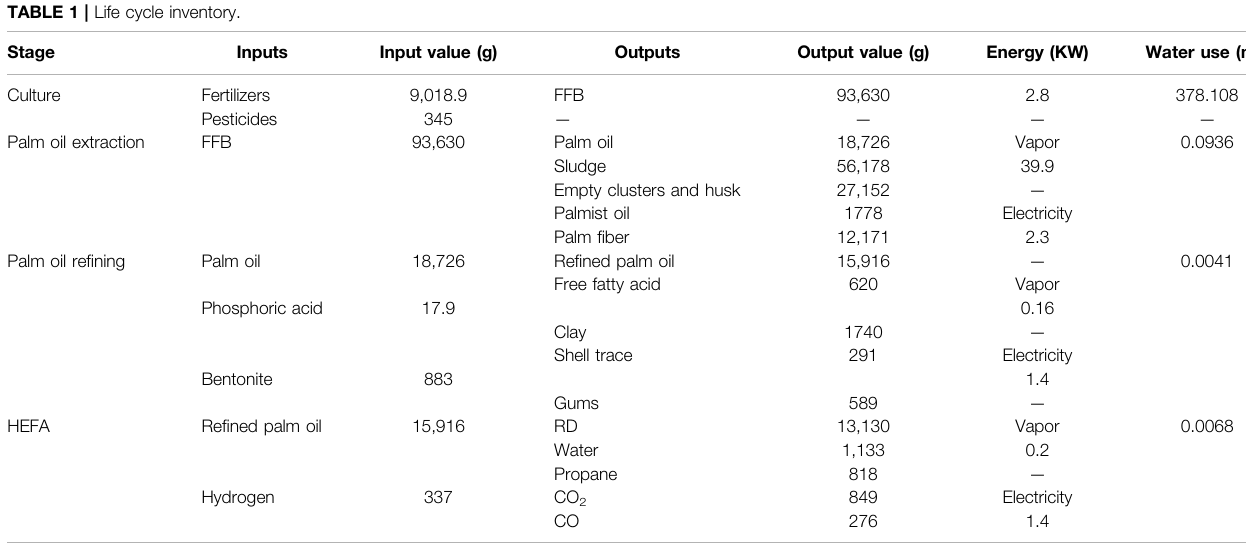
TABLE 1 | Life cycle